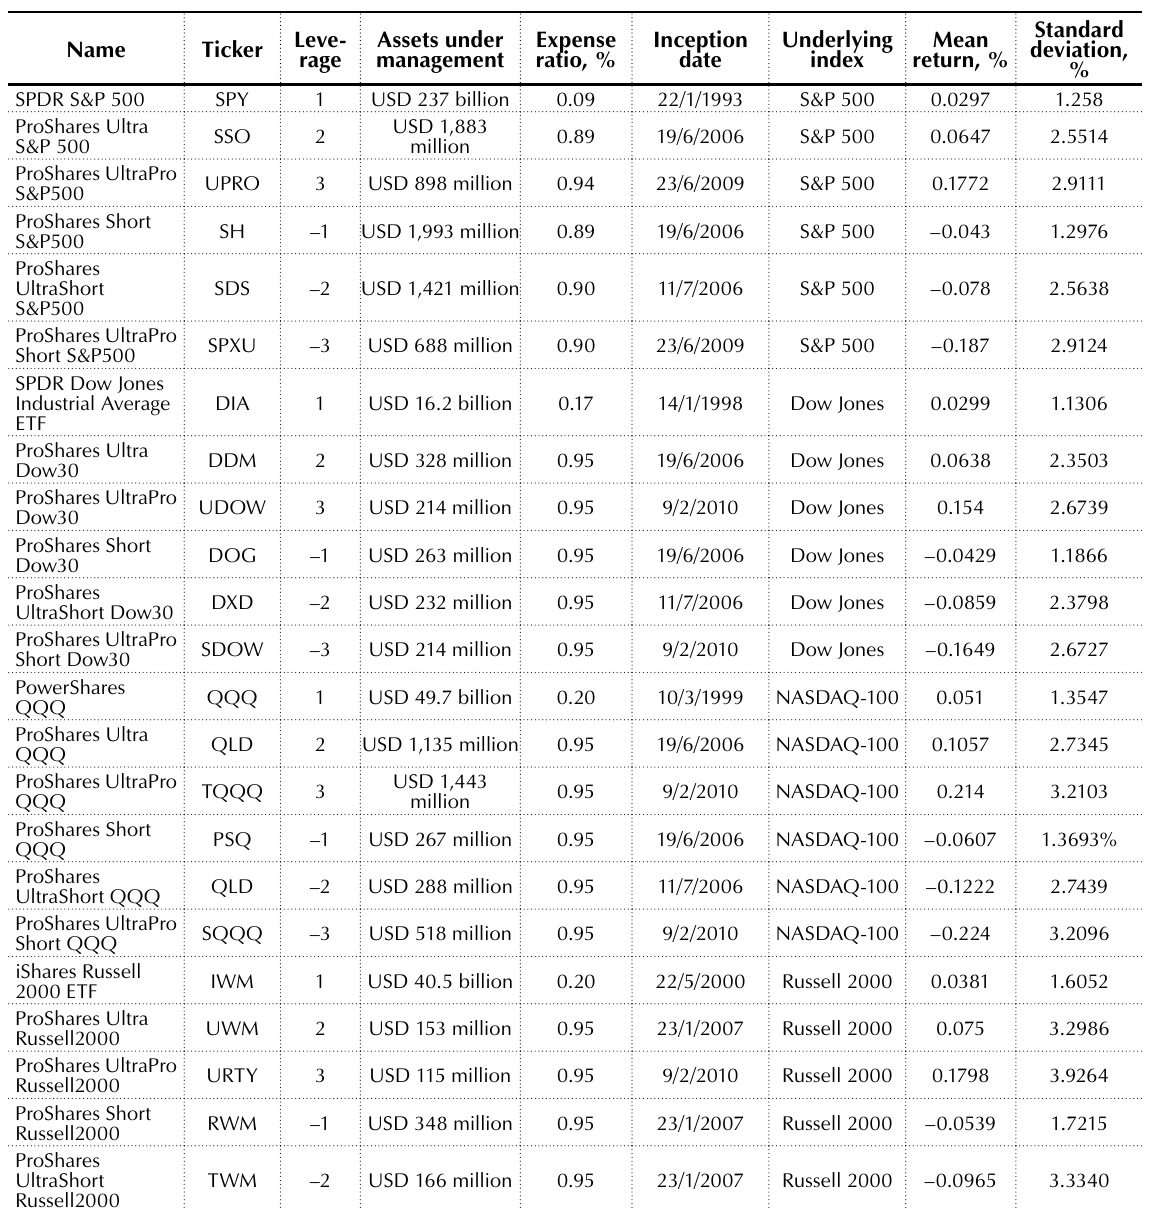
Table 3. ETF characteristics and descriptive